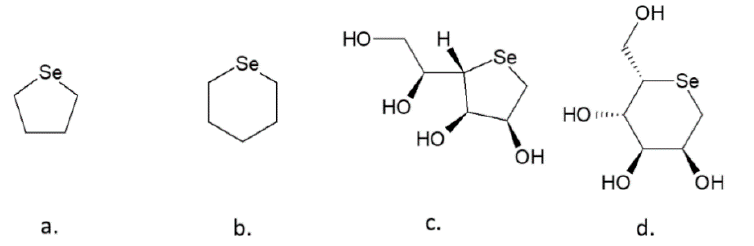
Figure 1. Structures of the trahydroselenophene ( a ), selenane ( b ), and some derivates: 1,4-anhydro- 4-seleno-hexofuranose (1,4-anhydro-4-seleno-D-talitol) ( c ) and 1,5-anhydro-5-seleno-hexopyranose (1,5-anhydro-5-seleno-D-mannitol) ( d ). Se-nucleosides are a specific group of carbohydrates with selenium bound in the sugar backbone. They cannot be converted into the corresponding nucleotides due to hampered capacity for enzymatic phosphorylation. Most of the Se-nucleosides are biolog- ically not active; however, the selenonucleoside developed by Jeong et al. showed anti- tumor activity against paclitaxel-resistant prostate cancer [234,235]. Regarding the seleno- pyranose derivatives of natural origin, the polysaccharides containing selenium atoms in their ring positions were investigated using the XAS (X-ray absorption spectroscopy) method [39].